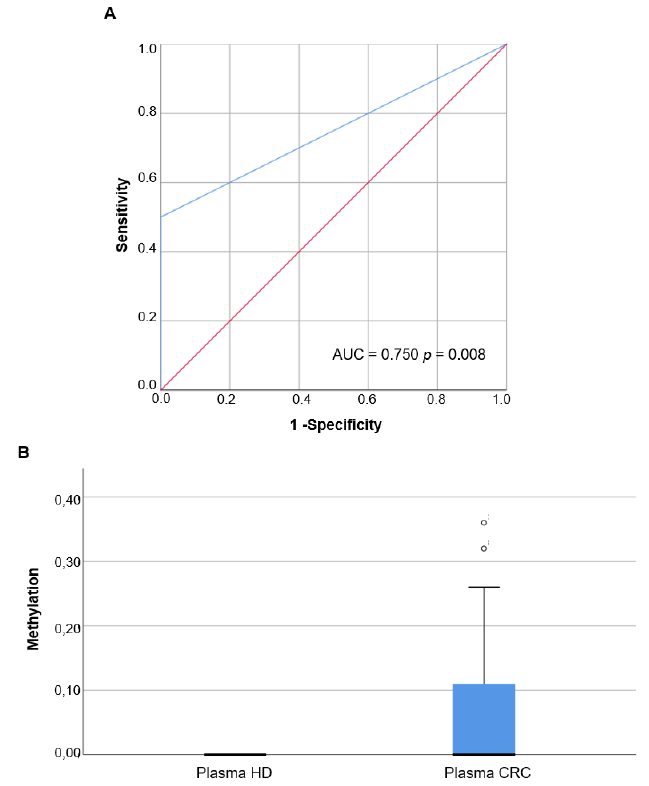
Figure 6. Droplet digital quantitative methylation-specific PCR (dd-QMSP) analyses of B4GALT1 in mCRC patient plasmas: ( A ) Receiver operating characteristic (ROC) curve analysis in the training set of tumor plasma samples ( n = 20) and plasma derived from healthy donors ( n = 19). Area under curve (AUC) = 0.750 (95% CI: 0.592–0.908, p = 0.008); ( B ) dd-QMSP in the validation set of tumor plasma samples ( n = 26) and plasma derived from healthy donors ( n = 19) (Mann–Whitney test, p = 0.001).